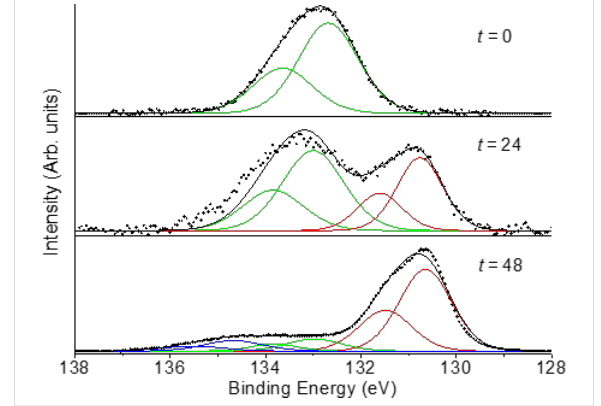
Figure 5: XPS analysis of samples form the reduction reaction of com- pound 6 : starting material (top), after 24 h (middle), after 48 h (bottom).